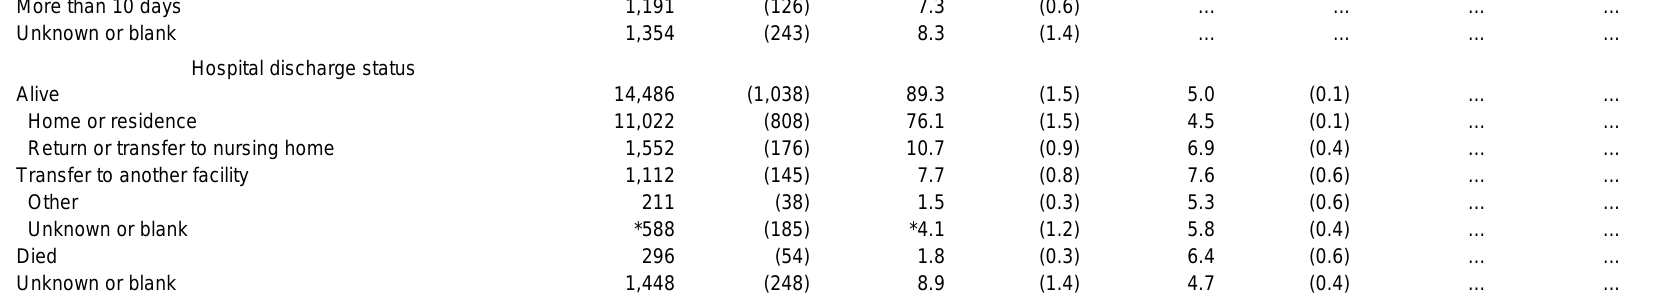
* Figure does not meet standards of reliability or precision. 1 Denominator for length of stay is 14,875,000 visits where this variable was known. Length of stay was unknown in 8.3 percent of visits resulting in admission. 2 Total exceeds "all visits" because more than one source of payment may be reported per visit. Workers' compensation, other, and unknown sources of payment are not included in this table, but account for 5.1 percent of expected sources of